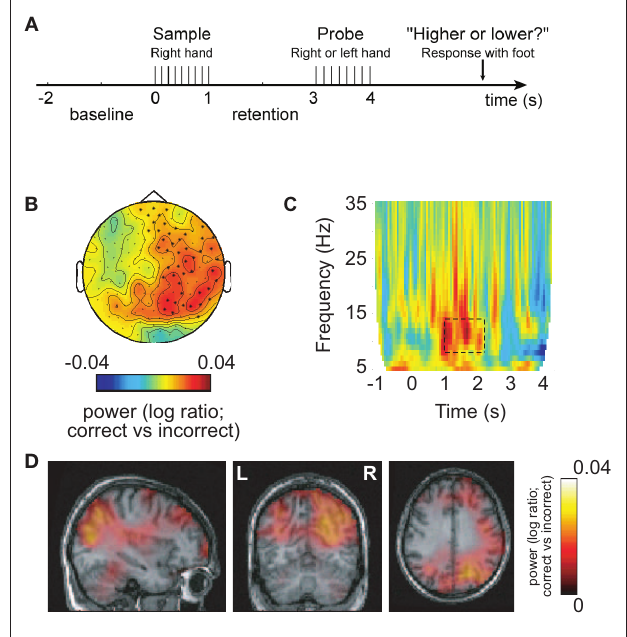
Figure 1 | Alpha activity in right sensorimotor areas predicts performance in a somatosensory working memory task engaging left hemisphere areas. This implies that functional inhibition of the right somatosensory cortex by alpha activity is predictive of successful performance. (A) Patterns of electrical stimuli were presented to the right hand and probed 2 s later. (B) When comparing the 8- to 13-Hz alpha activity in the retention interval between sample and probe (correct–incorrect), the right hemisphere alpha activity was stronger for successful performance. (C) Time–frequency representations of power showed that the task- dependent effect was constrained to the alpha band in the retention interval. (D) The alpha sources predicting successful performance were localized in areas including right sensorimotor and parieto-occipital regions. Reproduced with permission from Haegens et